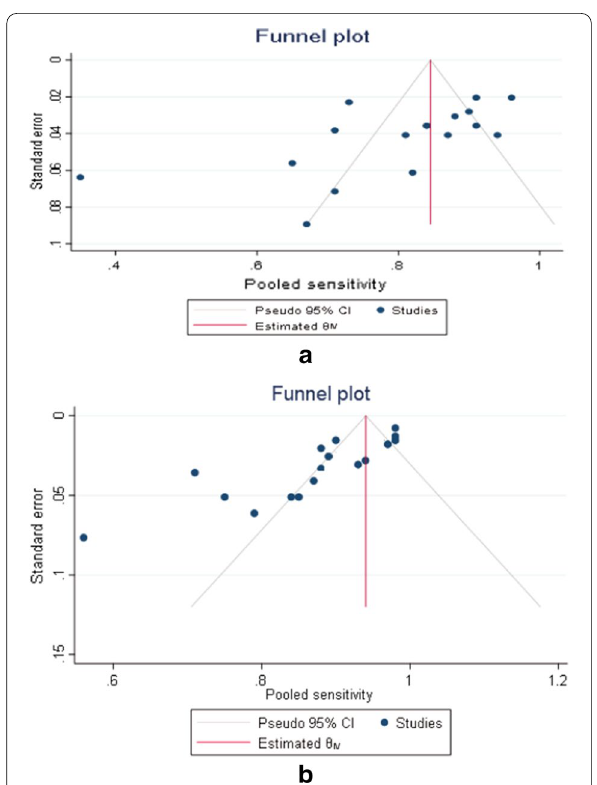
Fig. 7 The funnel plot to assess publication bias in estimated sensitivity ( a ) and specificity ( b